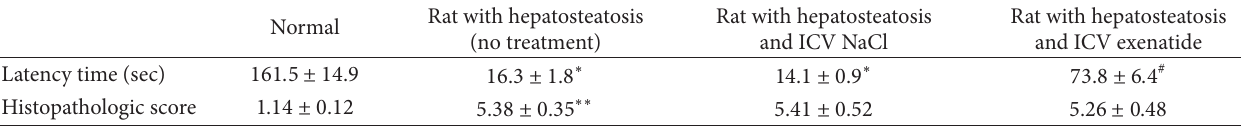
Table 1: Mean levels of latency time and histopathologic score were shown in study and control groups.